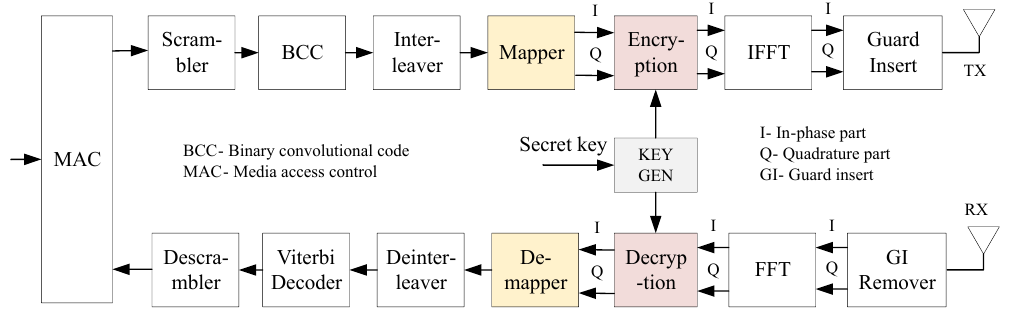
Figure 1. Block diagram of the physical layer transceiver